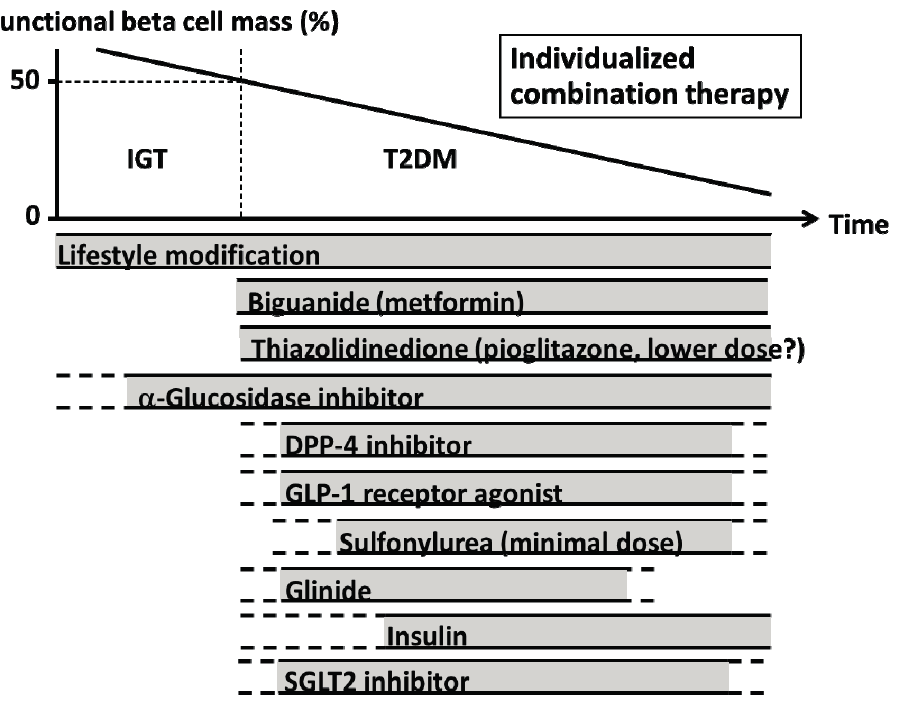
Figure 6. Proposed concept of treatment strategy for type 2 diabetes (T2DM) in relation to functional beta cell mass. An α -glucosidase inhibitor is partly approved for use in patients with impaired glucose tolerance (IGT) in Japan. Medications not approved or marketed in Japan are not included in the figure. Since currently no single therapy or agent can cure or even manage T2DM, an effective and individualized combination of current medications in addition to lifestyle modification aiming at reduction in beta cell workload is important to preserve or recover beta cell function, which may lead to a reduction in risk of severe